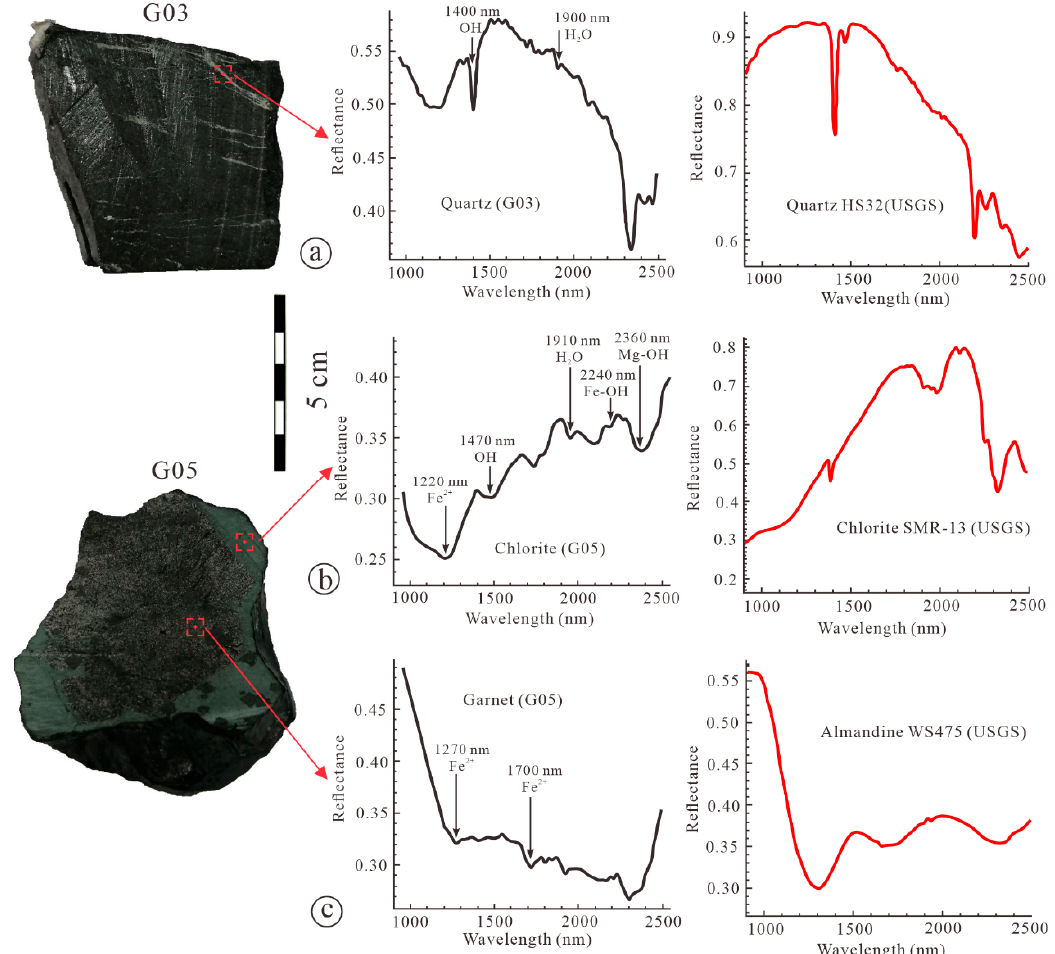
Figure 5. Spectral curves of different rock types and standard spectrum: ( a ) quartz; ( b ) chlorite; ( c ) garnet.